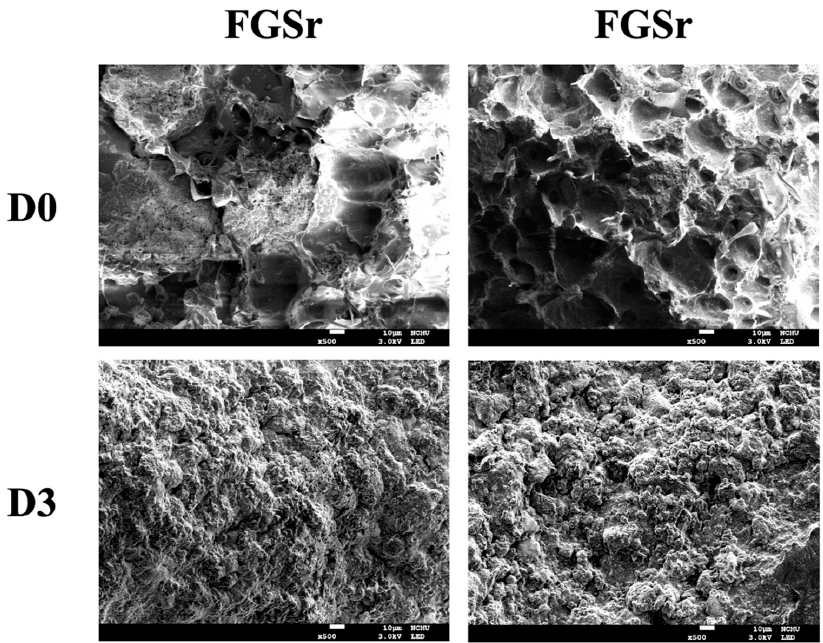
Figure 4. Microstructure images of the FGSr and FGSrB scaffolds before and after immersion in SBF. The scale bar is 10 µm. The scale bar is 10 µ